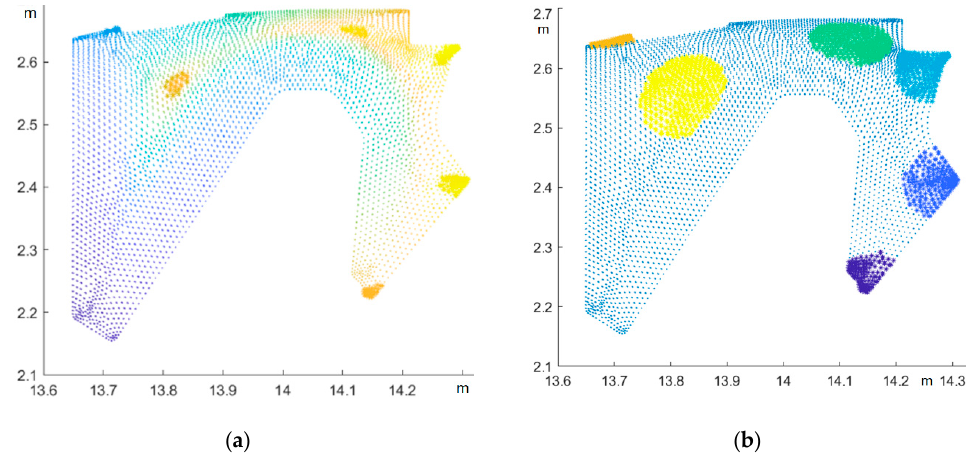
Figure 22. Separation of individual closable spots ( a ) and reconstruction of their original shape at the time of closure ( b ).